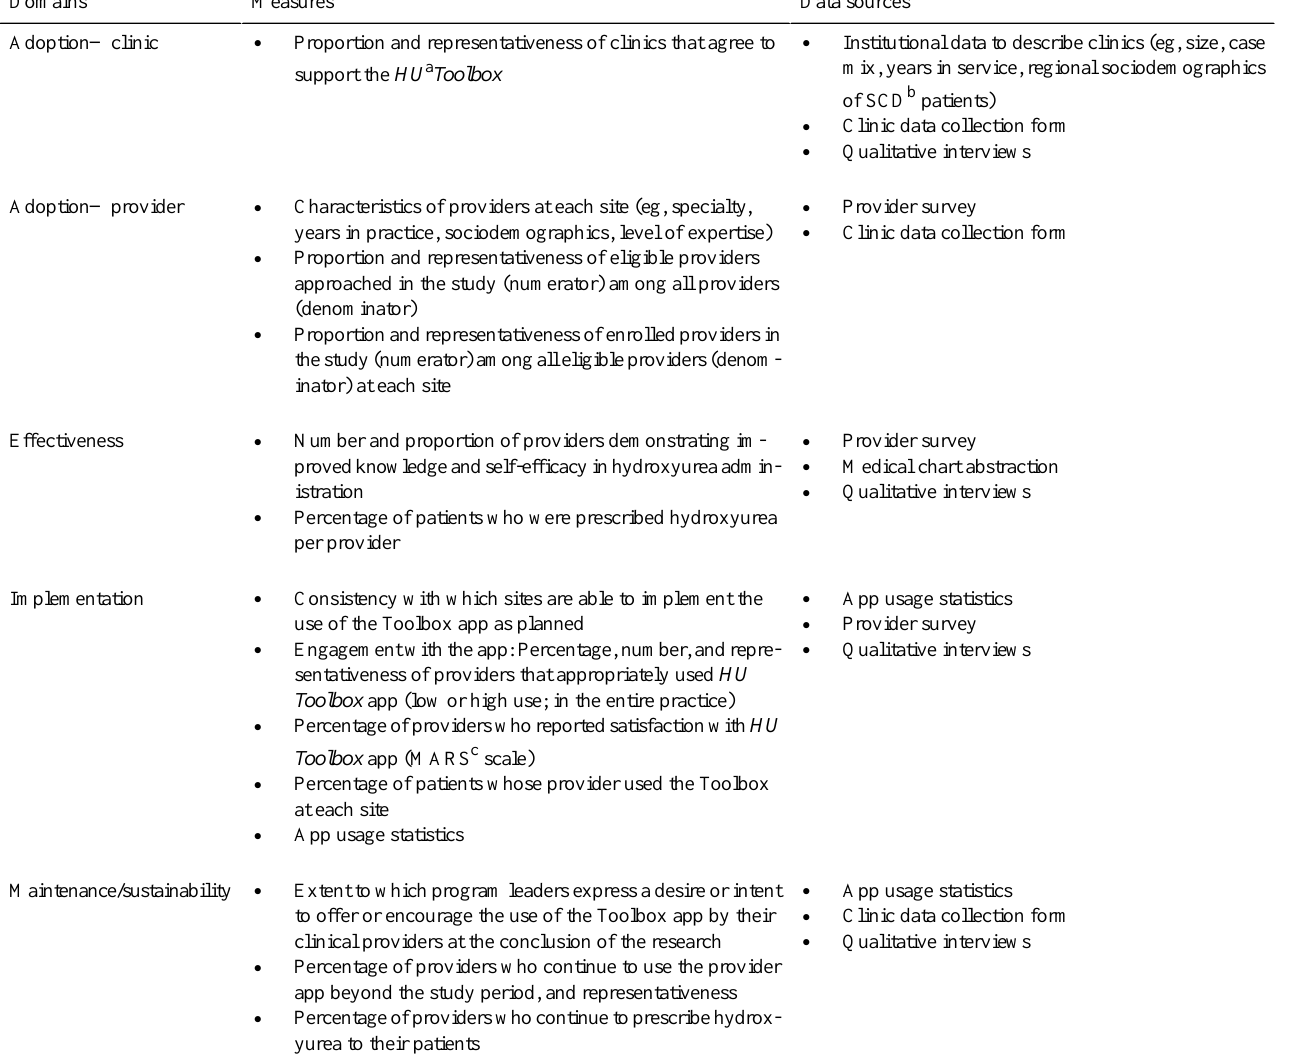
Table 4. The reach, effectiveness, adoption, implementation, and maintenance evaluation measures of Hydroxyurea Toolbox